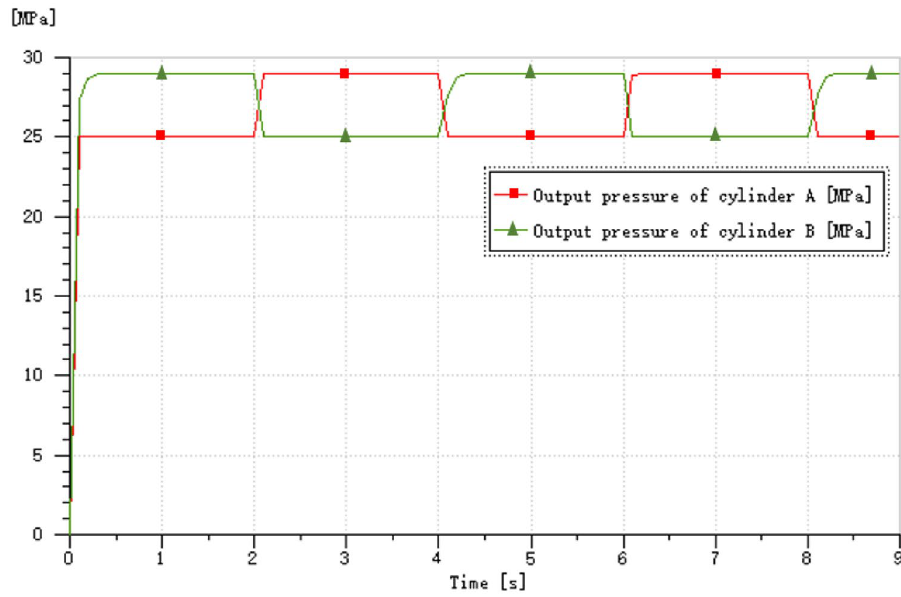
Fig. 13 Output pressure curve of the plunger